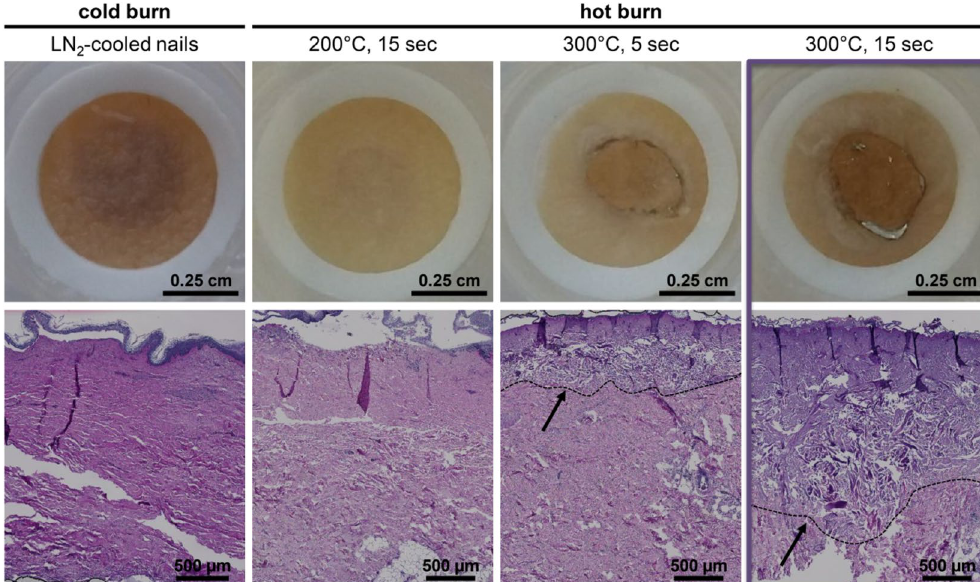
Figure 1. Application of a 300 °C hot soldering iron for 15 s induces deep second-degree burn wounds to human skin explants. Macroscopic (top) and microscopic PAS appearance (bottom) of skin after burn injury shows mild to profound tissue damage (burned, non-debrided, non-infected, no neutrophil supplementation). Cold burn induced by pressing liquid nitrogen-cooled brass nail for 1 min to the skin surface resulted in darkening of the skin surface and a separation of the epidermis from the dermis, inducing only a first-degree burn (day 6; N = n = 2). Hot burn was induced by using a preheated soldering iron. Only the condition of 300 °C and 15 s induced a deep second-degree burn as indicated by the disrupted collagen structure (day 1; 200 °C 15 s N = n = 1, 300 °C 5 s N = n = 1, 300 °C 15 s N = 3, n = 6). N = number of donors, n = number of technical replicates. Lines and arrows indicate the border from the intact to the disrupted collagen